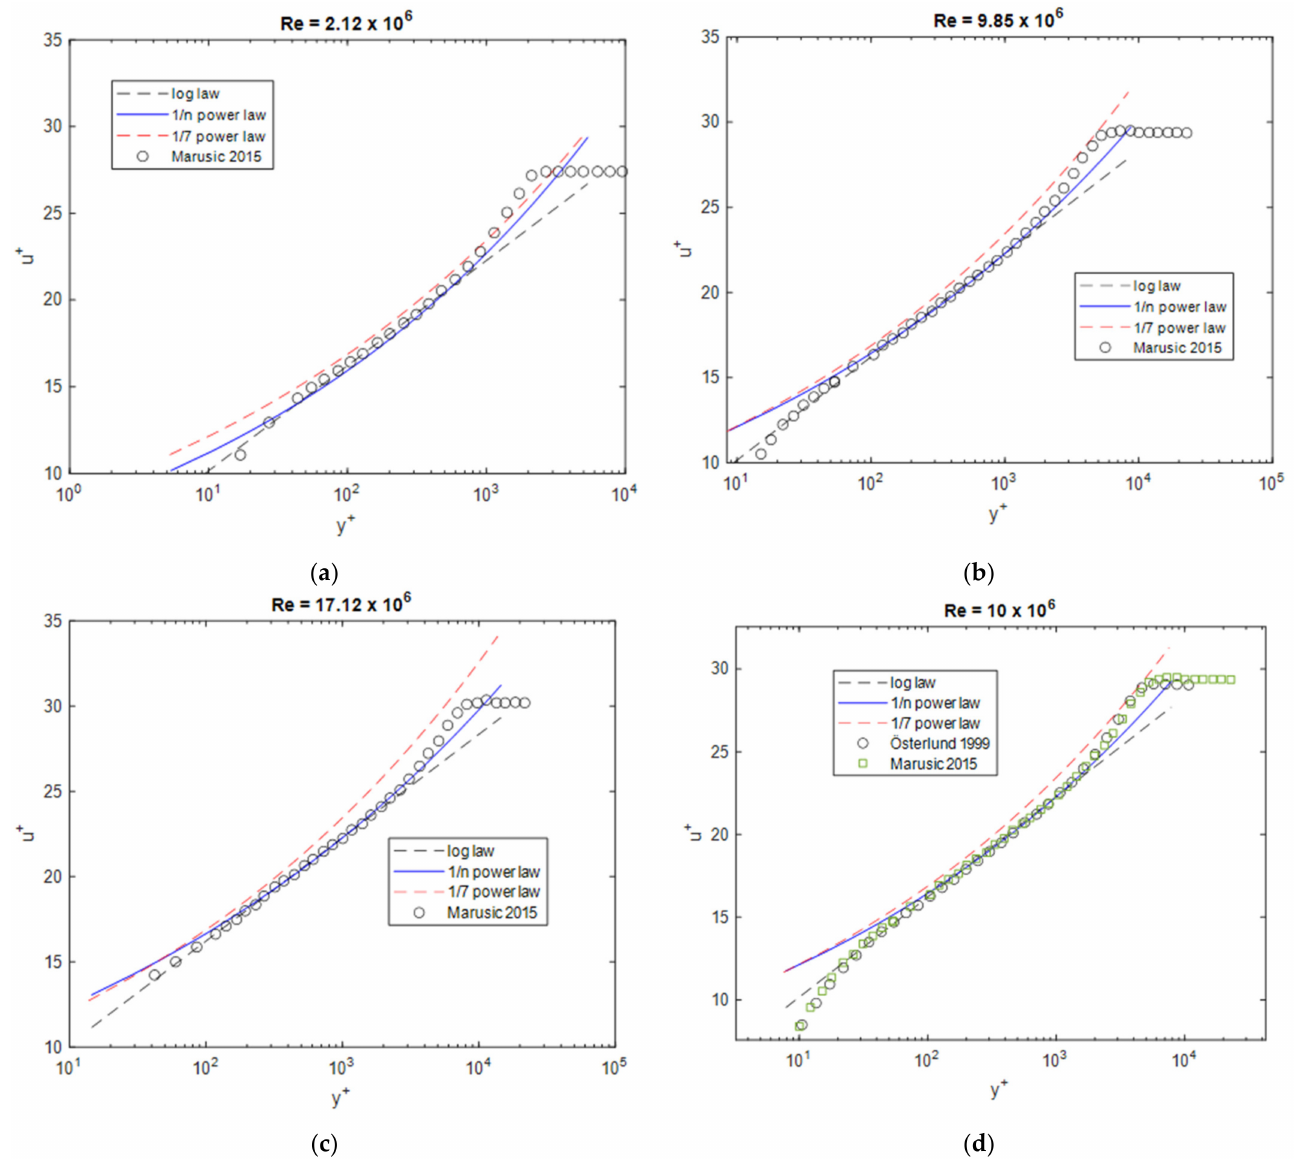
Figure 7. Boundary layer profiles at different Reynolds numbers Re x compared to the data from Marusic et al. [13] and Österlund [10], ( a ) Re = 2.12 × 10 6 , ( b ) Re = 9.85 × 10 6 , ( c ) Re = 17.12 × 10 6 , ( d ) Re = 10 × 10 6